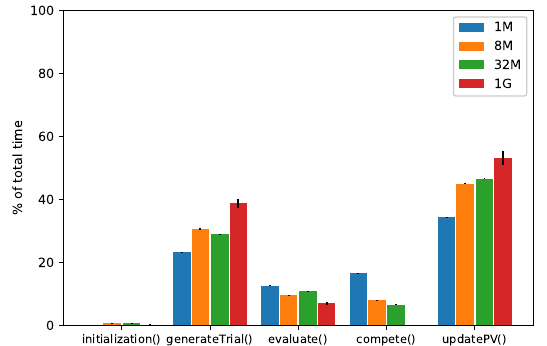
Figure 2. Time profiling (mean ± std. dev. across 10 runs) for the cGA-A100 on the OneMax problem in four different